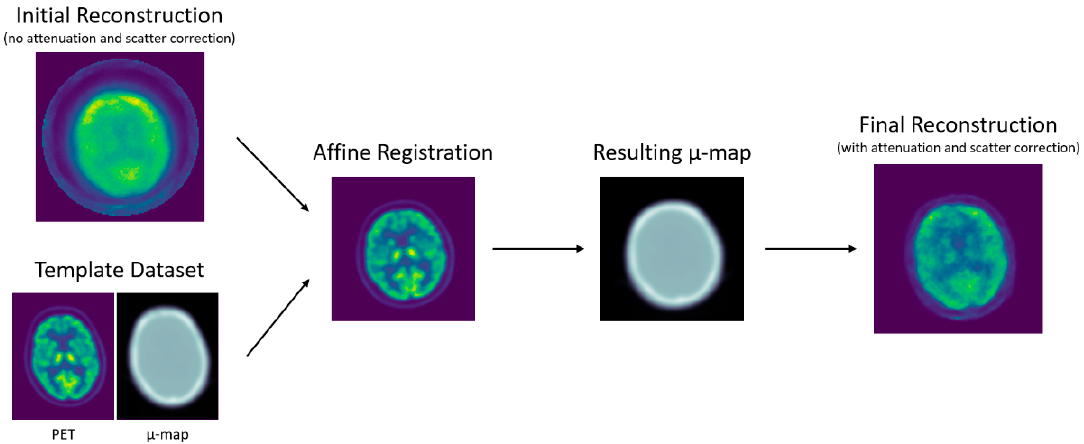
Figure 2. Diagram of the reconstruction workflow, where the template PET and uncorrected BPET image are registered, and the equivalently deformed µ-map is used for attenuation (and scatter) correction. The initial reconstruction is the BPET emission image that was reconstructed without attenuation and scatter correction. The template dataset is a set of PET image and CT-generated µ-map from the reference PET/CT scanner. The affine registration is the template PET after being registered to the initial reconstruction, and the resulting µ-map was obtained by applying the same transformation to the template µ-map. This µ-map was then used to perform the attenuation and scatter correction to obtain the final reconstruction .